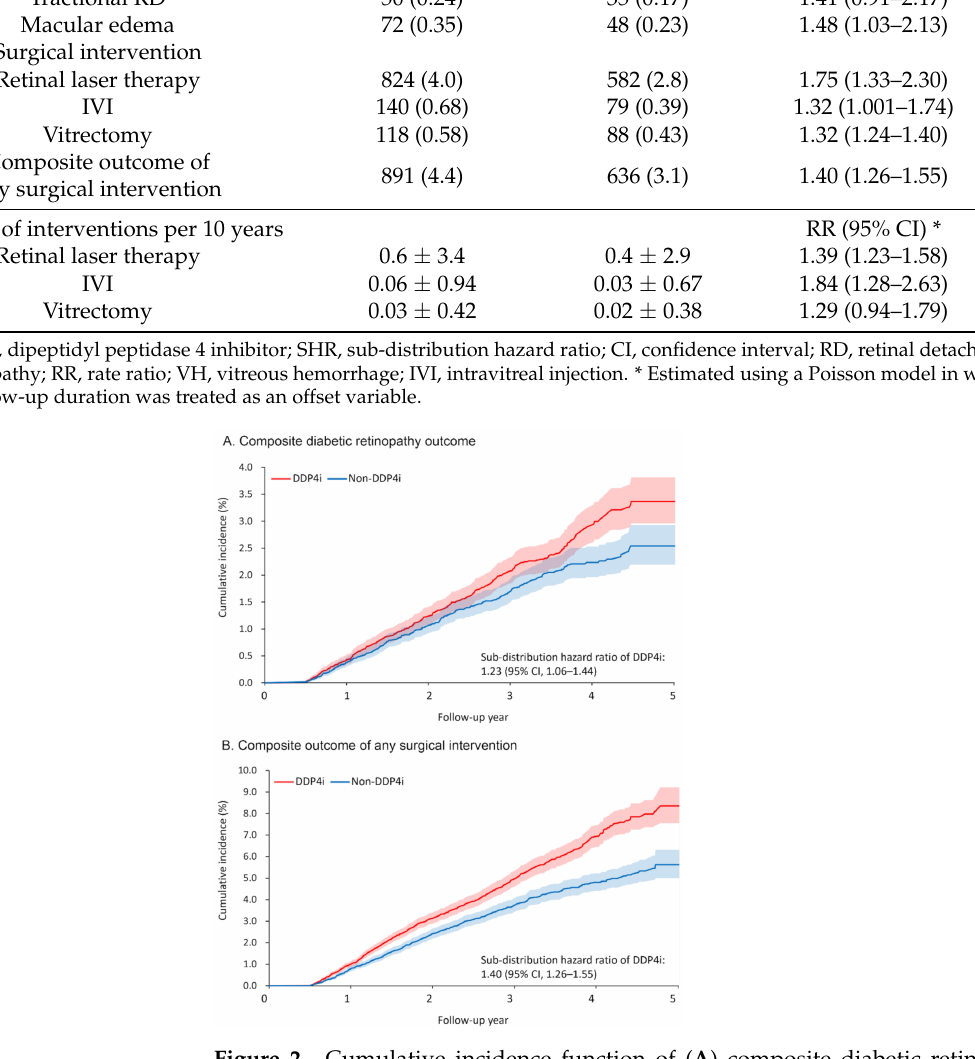
Figure 2. Cumulative incidence function of ( A ) composite diabetic retinopathy outcome and ( B ) composite outcome of any surgical intervention between the DPP4i and non-DPP4i group after propensity score matching. DPP4i, dipeptidyl peptidase 4 inhibitor; CI, confidence